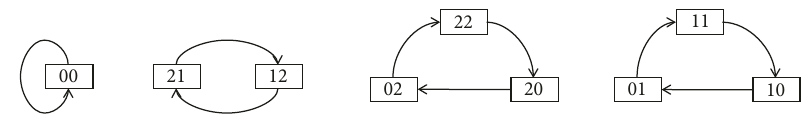
Figure 3: State diagram of NFSR1 in Example 21.